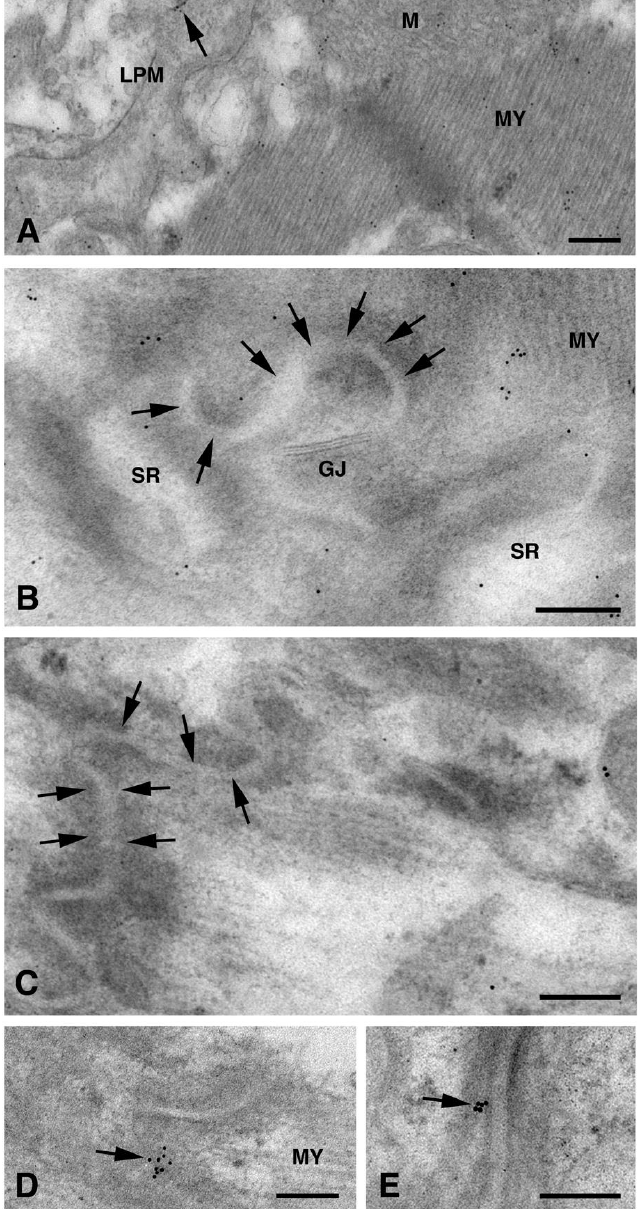
Figure 4. TEM immunogold analysis for Cx26 and Cx43 in cardiomyocytes of heart tissue. ( A – C ) Cx26 immunogold analysis. ( A ) Lateral plasma membrane (LPM) of two adjacent cardiomyocytes showing scarce amount of gold particles (arrow). Scale bar 200 nm. ( B , C ) Representative images showing no immunoreaction on intercalated discs (arrows) as well as on gap junctions (GJ). Scale bars 100 nm. ( D , E ) Cx43 immunogold analysis. Arrows point to gold particles mainly at level of intercalated discs. Scale bars 200 nm. M, mitochondrion; MY, myofibrils; SR sarcoplasmic